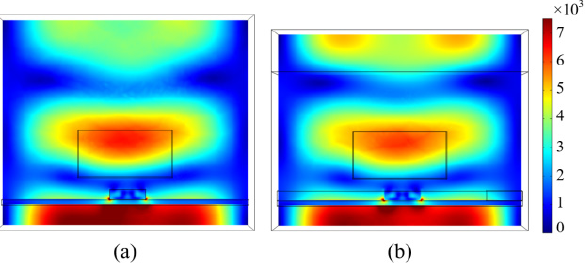
Figure 6. Electric field distribution at discrete height and transform height ( t = 10 s): ( a ) discrete height; ( b ) proposed method.